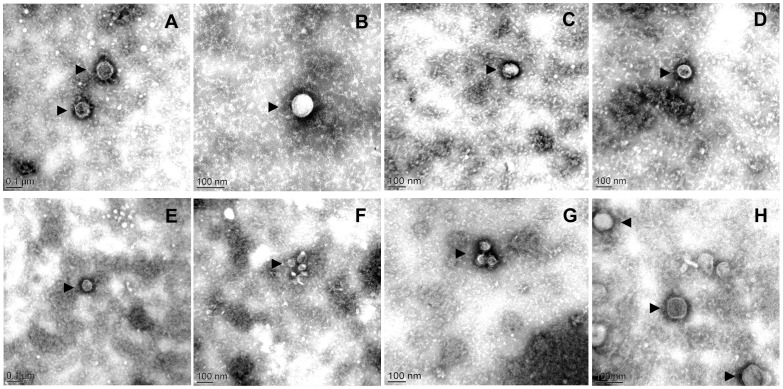
Electron micrographs of negatively-stained EV purified from A. laidlaiwii PG8T (A), M. mycoides subsp. mycoides Afadé (B), M. mycoides subsp. capri PG3T (C), M. capricolum subsp. capricolum L15937 (D), M. agalactiae 5632 (E), M. agalactiae L14628 (F), M. bovis L15762 (G) and M. fermentans PG18T (H).Examples of EV are indicated by black arrowheads.